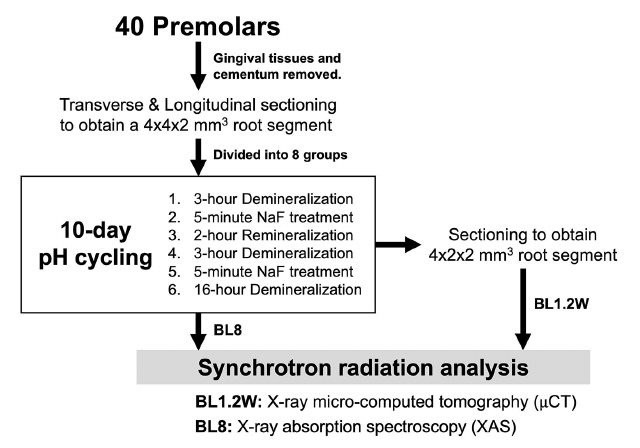
experimental study.